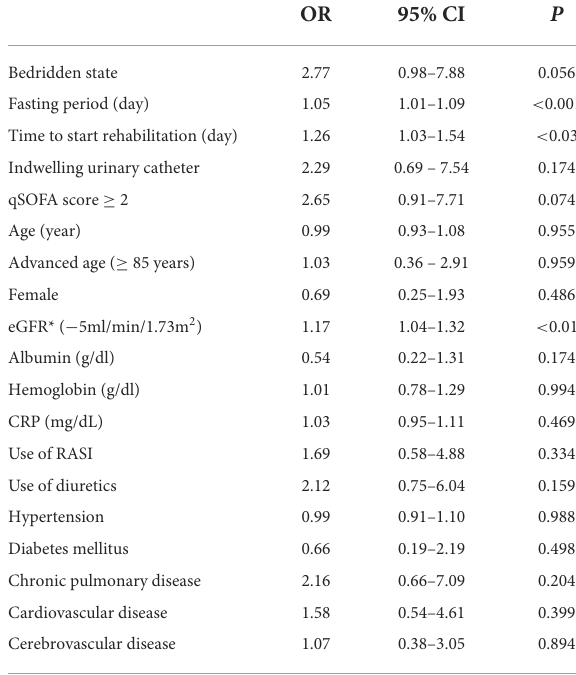
TABLE 2 Analysis of factors associated with longer LOSs in univariate analysis.